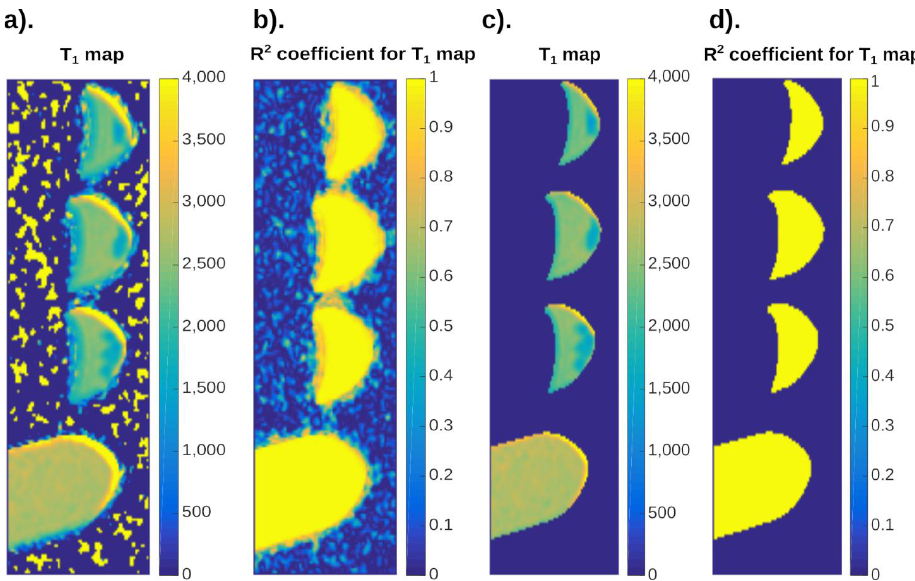
Figure 5. Practical application of neuronal analysis in cell cultures. Distribution of T 1 values for the MCF-7 cell culture: ( a ) maps showing the distribution of T 1 times before the neural network analysis; ( b ) phantom maps showing the distribution of fit coefficient R 2 values before the neural network analysis; (c) maps showing the distribution of T 1 times after the neural network analysis; (d) phantom maps showing the distribution of fit coefficient R 2 values after the neural network analysis. Noise reduction is clearly visible. The signal from the test tubes, which is an artifact, was also largely eliminated.